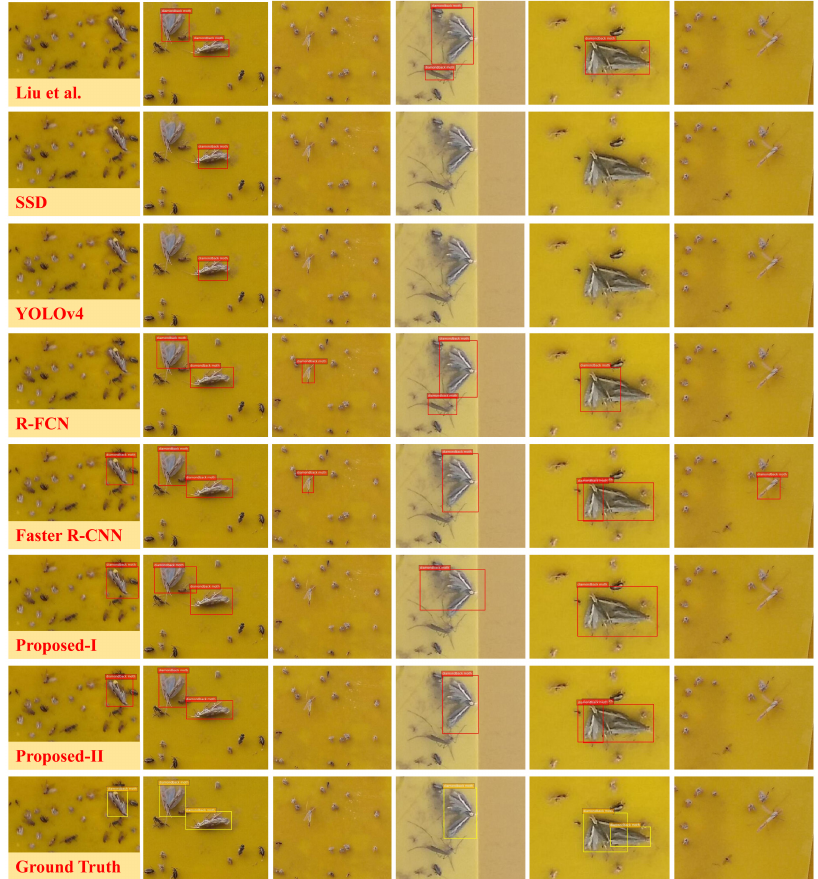
Figure 6. Some examples of the detection visualization results on the testing set. Rows 1–6 are results from LIU, SSD, YOLOv4, R-FCN, Faster R-CNN, Proposed-I, Proposed-II and ground-truth, respectively, and Columns 1–6 are different insect pest